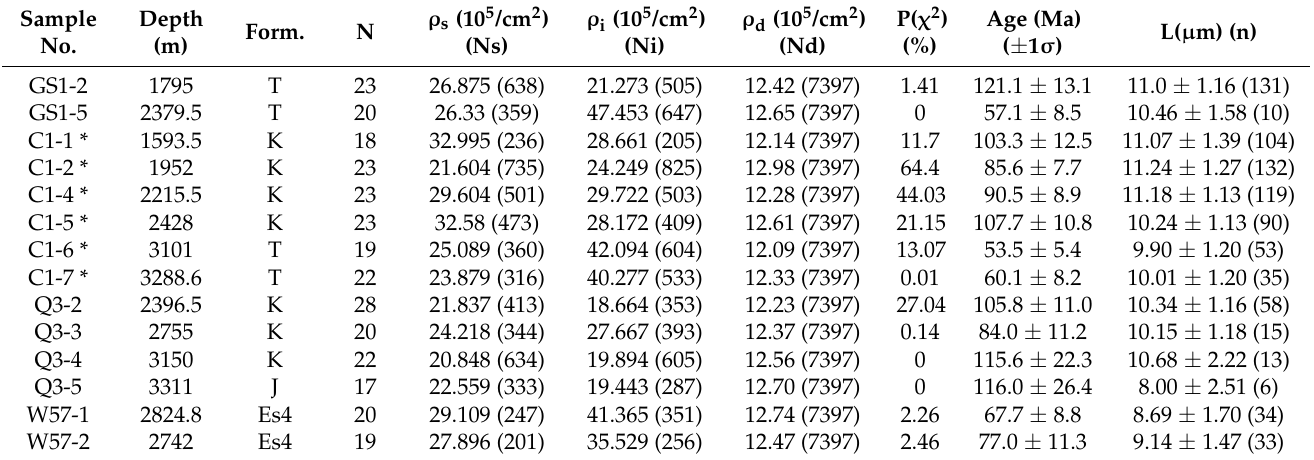
Table 1. Apatite fission-track data from borehole samples in the Linqing